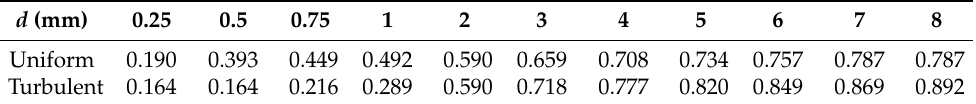
Table 1. Catch ratios obtained for each solid particle size d at U ref = 2.5 m s − 1 using the LPT model and based on the large eddy simulation (LES) mean airflow fields for the Geonor precipitation gauge under uniform and turbulent free-stream conditions.